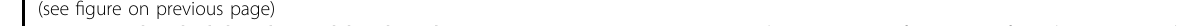
Fig. 1 Mitochondrial disorder modeling by DdCBE in rat. a Representative sequence chromatograms of G7755A (Left) and G14098A (Right) founder rats. Target sites are indicated by red arrows. b Frequencies of G-to-A conversion at G7755 (Blue dots) and G14098 (Red dots) in founder rats. c Frequencies of mtDNA G-to-A conversion of offspring from G14098A #7 founder. The red dot indicates founder, black dots indicate F1 offspring. d Measuring distance (Left) and speed (Right) by open fi eld test. e Evaluation of motor coordination by Rotarod test. f Measuring grip strength by Grip Strength Test. g – m Echocardiography analysis of wild-type rats and edited F1 males. The tests include a snapshot of M-mode of echocardiography ( g ), left ventricular (LV) diameter at end-diastole and end-systole (LVIDD, LVIDS) ( h , i ), LV anterior wall thickness at end-diastole and end-systole (LVAWD, LVAWS) ( j , k ), LV ejection fraction (LVEF) ( l ), and LV percent fractional shortening (LVFS) ( m ). Data were presented as a scatter dot plot with means ( n = 4 for wild-type control, n = 5 for G14098A F1 rats). Signi fi cance was calculated with unpaired two-tailed Student ’ s t -test (* P < 0.05, ** P < 0.01, *** P <